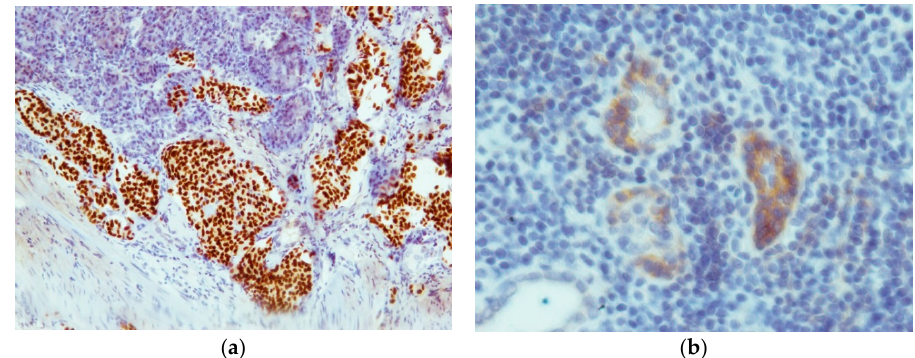
Figure 3. ( a ) 10× magnification, showing thyroid transcription factor-1 (TTF-1) expression in a metastasis in a Meckel’s diverticulum; ( b ) 40× magnification, illustrating epidermal